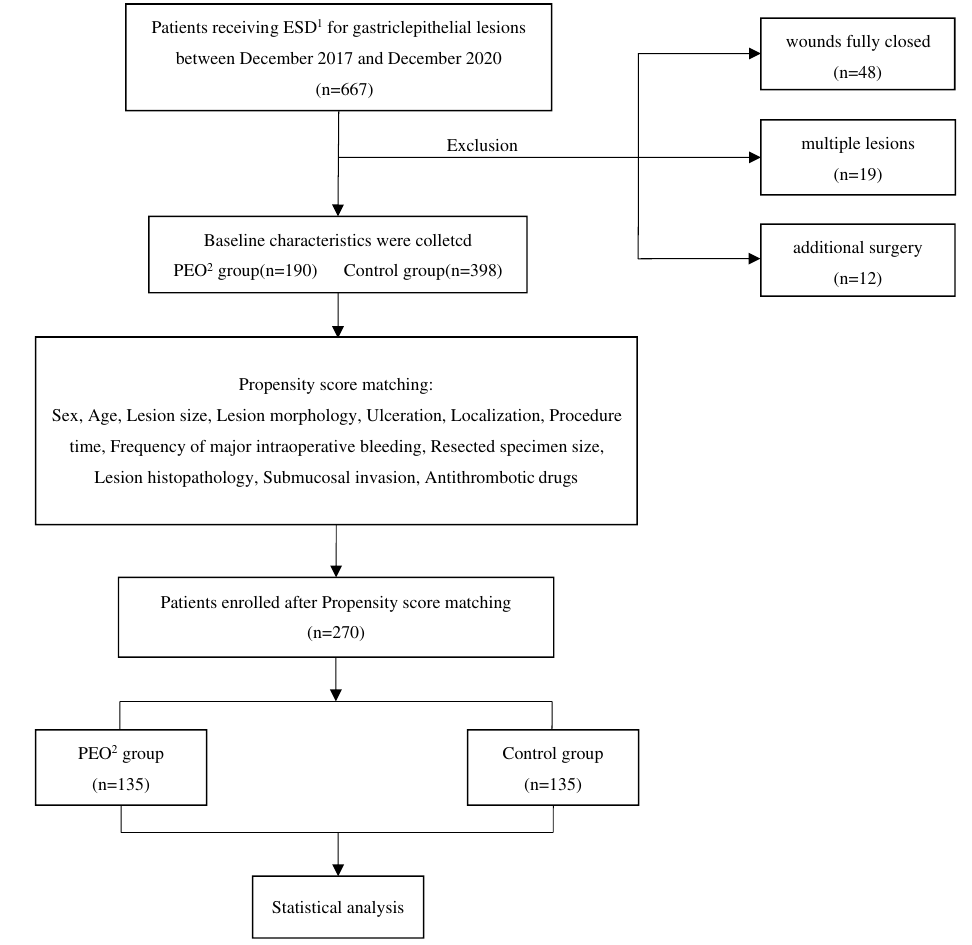
Figure 3. Flow diagram of patient selection for propensity score matching. 1 ESD endoscopic submucosal dissection, 2 PEO polyethylene